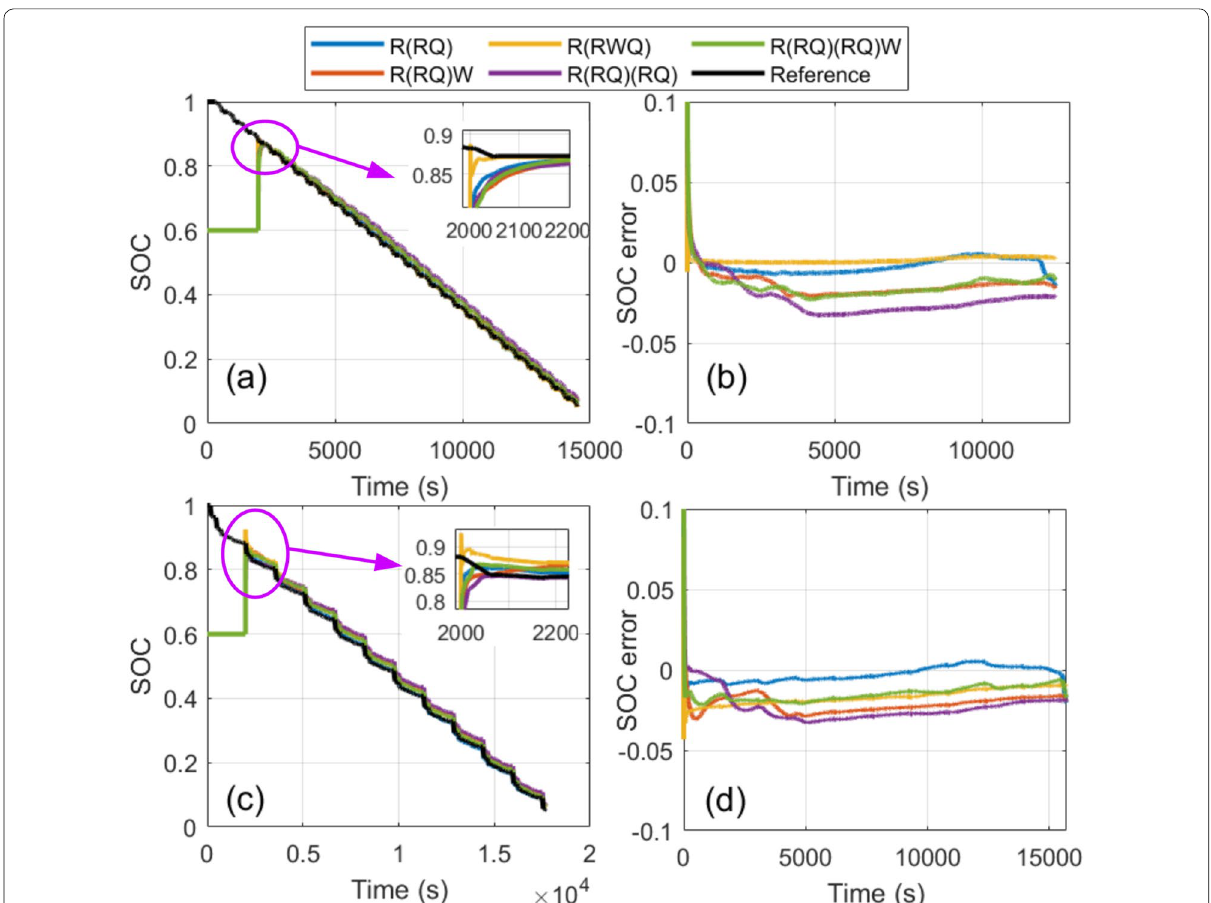
Figure 6 Estimation results of 5 FOMs: a SOC estimation results for DST profile, b SOC estimation error for DST profile, c SOC estimation results for UDDS profile, d SOC estimation error for UDDS